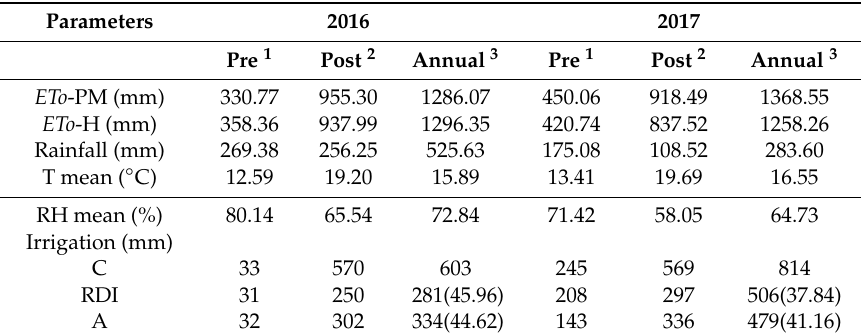
Table 2. Reference evapotranspiration ( ETo ), rainfall, mean temperature, mean air relative humidity, and total irrigation water applied in the three irrigation